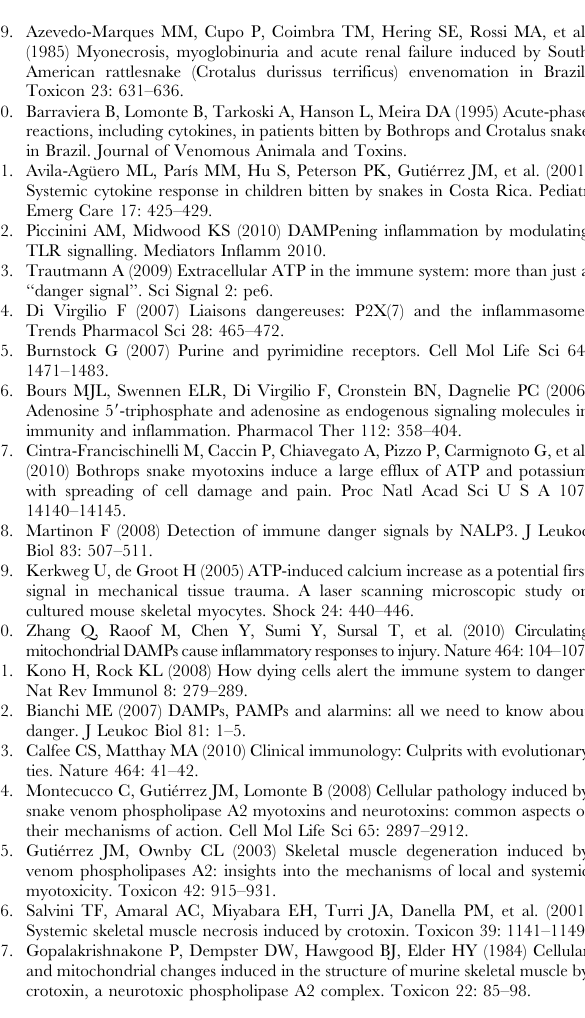
Figure S1 LDH release in ex vivo mice muscles. Tibialis anterior muscles were uncovered by skin dissection, removed and placed in 1 ml of physiological solution containing 50 m g/ml of venom. LDH enzymatic activity was determined in the superna- tants of B. asper (triangles) and C. durissus terrificus (squares) treated muscles for the indicated time points. Circles indicate the LDH activity in mock treated control muscles. Data represent the means of four independent experiments. The release of LDH is as an index of loss of membrane